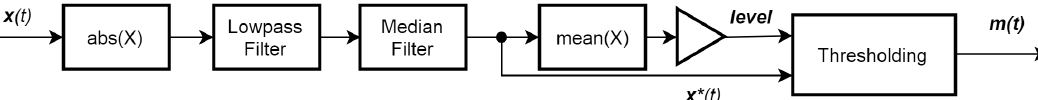
Figure 4. Correct message recognition in ideal channel ( a ) and incorrect recognition in noised channel (SNR = 5dB) ( b ).